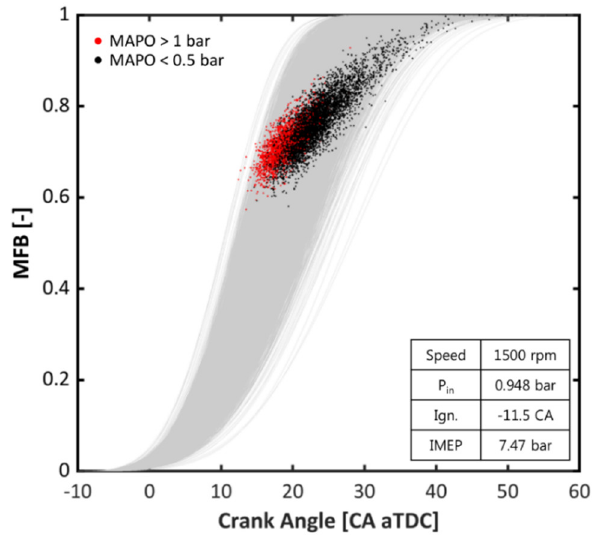
Figure 16. Knock onset, intensity and mass fraction burned